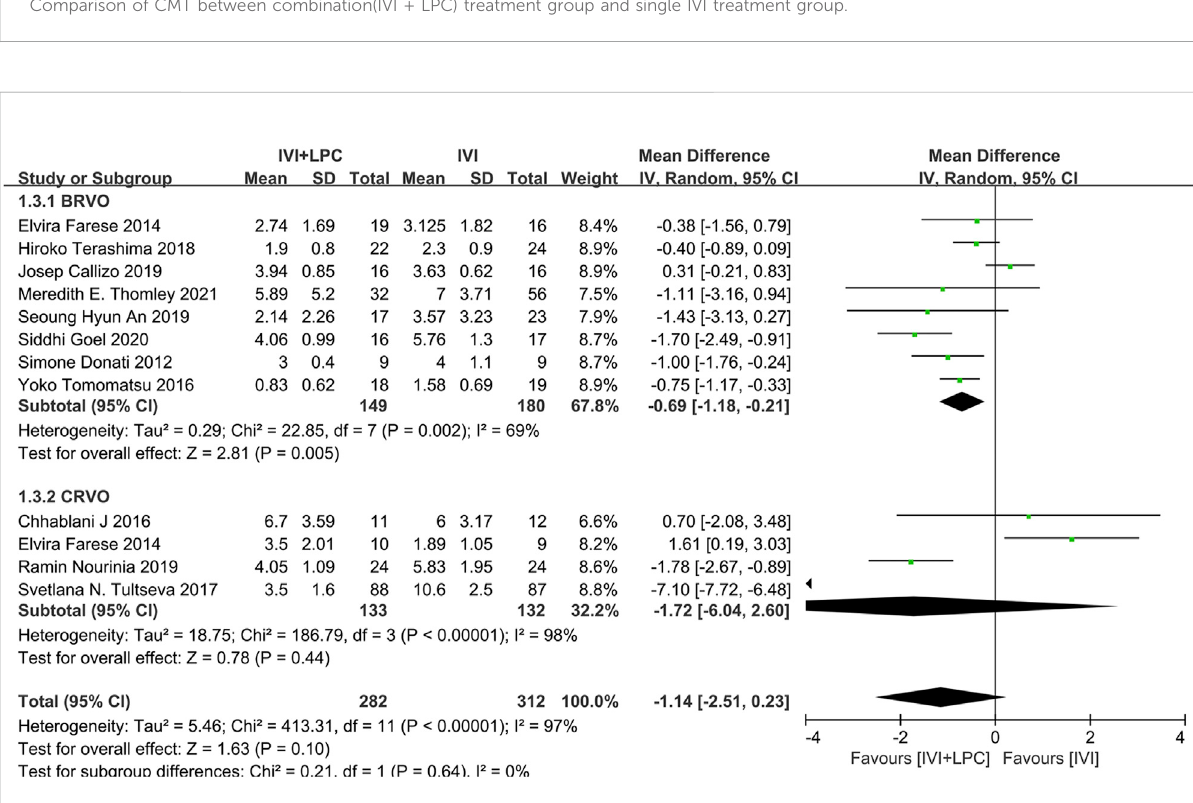
FIGURE 5 Comparison of the number of injections between combination(IVI + LPC) treatment group and single IVI treatment group.